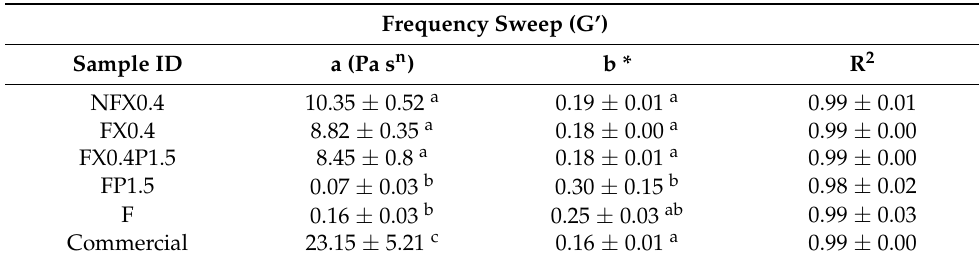
Table 9. Frequency sweep test values for samples. Data are presented as mean values of triplicates ± standard deviation. The third sample of FP1.5 was